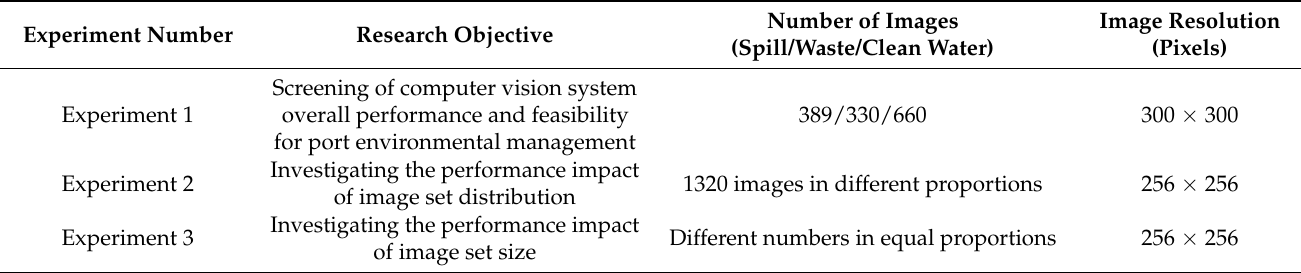
Table 1. Summary of computer vision experiments in the current